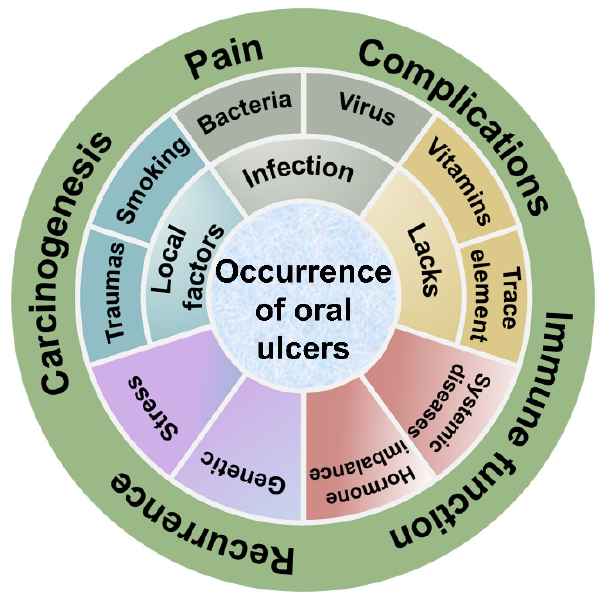
Figure 2. The causes and dangers of oral